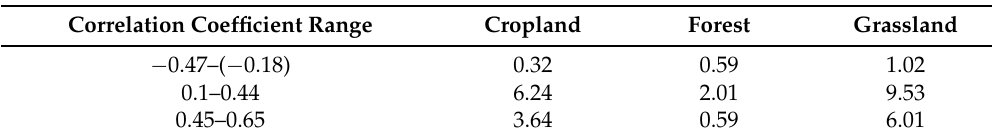
Table 4. Percentage of land cover class with significant correlation coefficients Normalized Difference Vegetation Index (NDVI)/